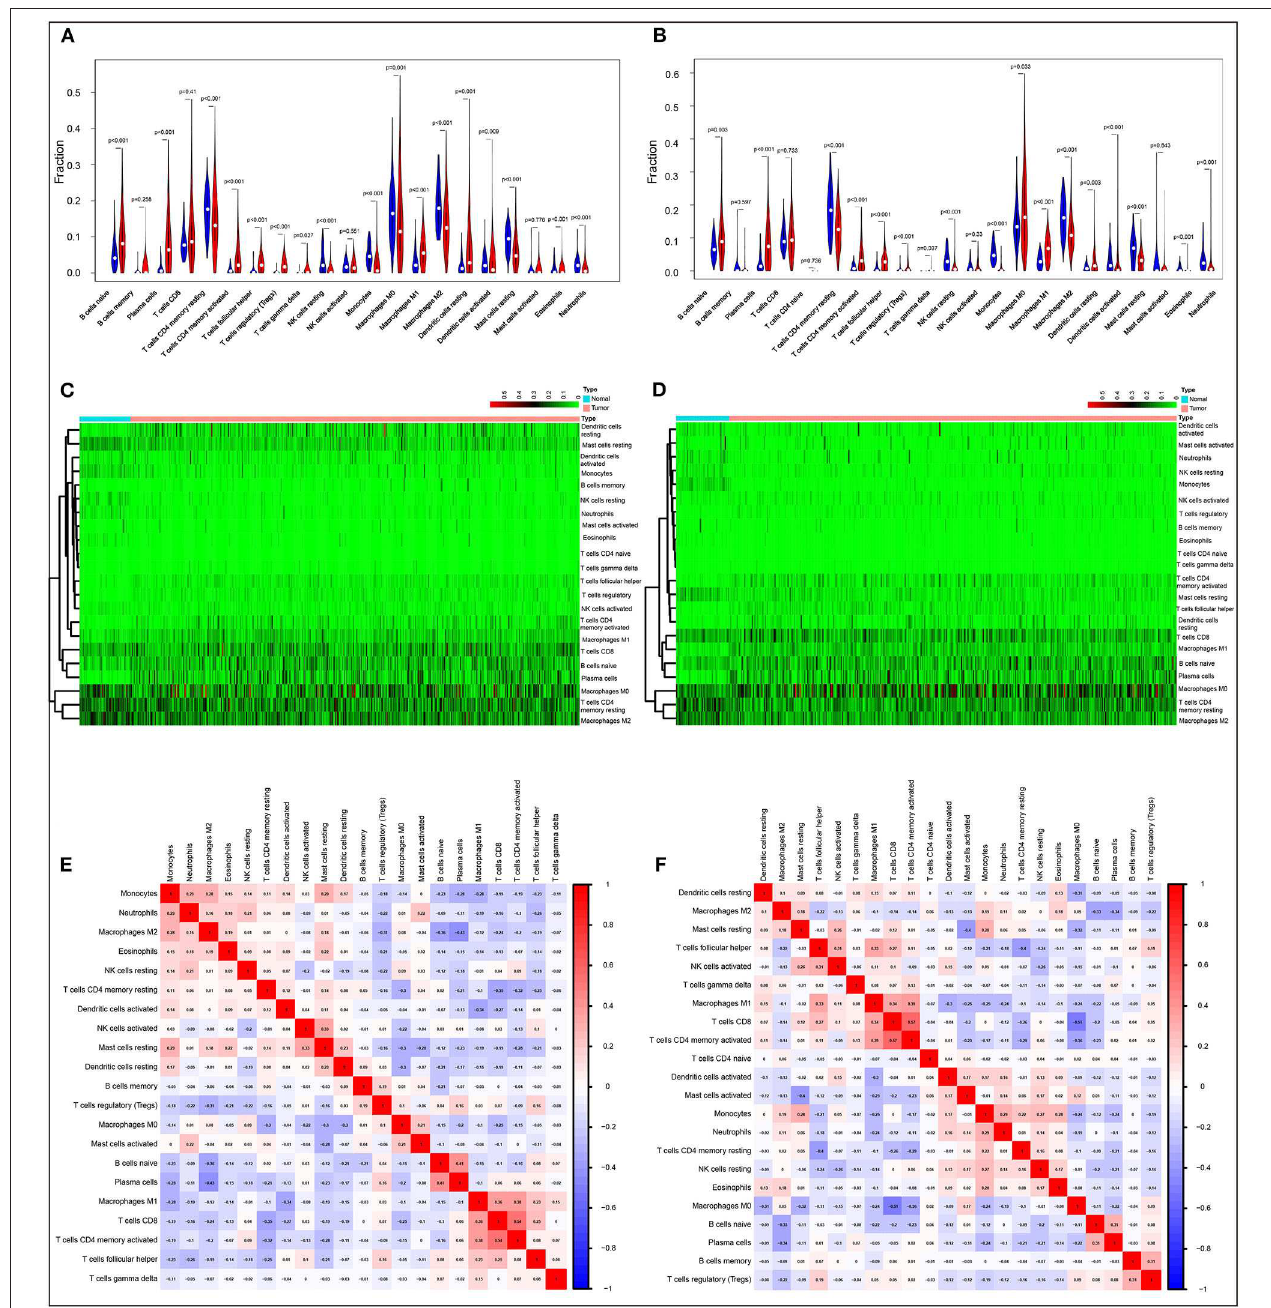
FIGURE 1 | Evaluation of the proportions of 22 types of immune cell infiltration by Cell Type Identification By Estimating Relative Subsets Of RNA Transcripts method in The Cancer Genome Atlas lung cancer cohorts. Violin plots and heatmaps indicated the differences in the immune cell distribution between malignant (red) and normal (blue) tissues in LUAD (A,C) and LUSC (B,D) cohorts. Different correlation patterns among 26 immune cell subsets in LUAD (E) and LUSC (F) cohorts.